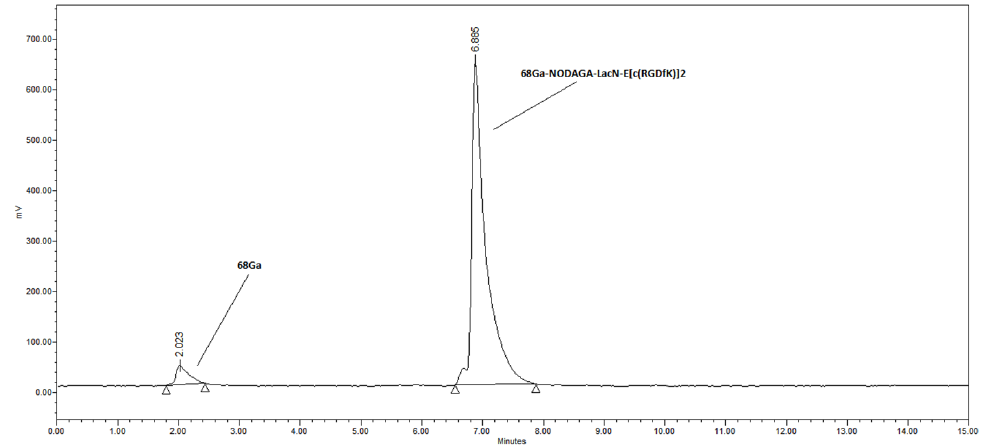
Figure 1. Radio-HPLC chromatogram of the reaction mixture using 32 µM ligand concentration and 15 min reaction time at 95 °C.